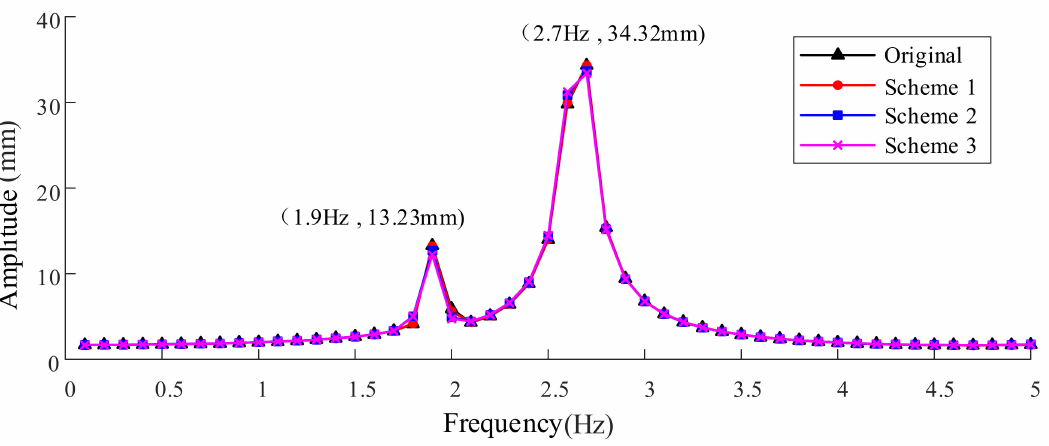
Figure 9. The vibration amplitude of the original large headframe and the improved headframe under the schemes 1, 2, and